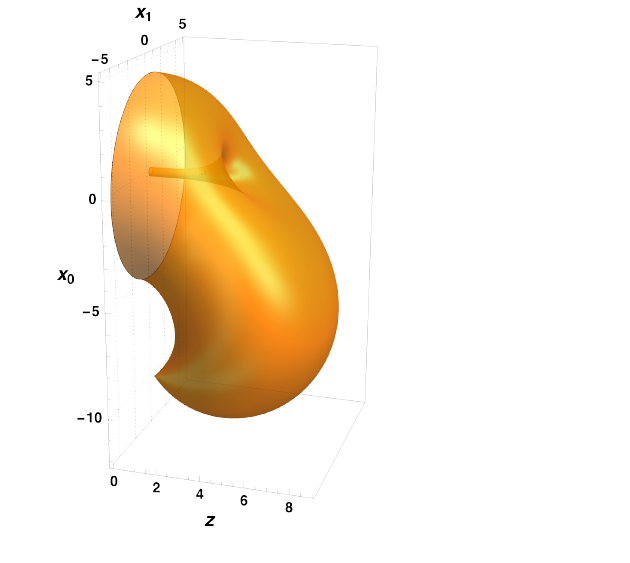
Figure 4 . A 2D contour of the Lagrangian density (3.24) (multiplied by the volume factor 4 πx 3 and for ρ = 1 , d = 10 ) evaluated at 1. An anti-instanton appears at x 0 = − 10 and x 1 = x 2 = x 3 = 0 (Euclidean coordinates x 2 , 3 are not shown) whose size grows and meets at z ∼ d the instanton located at x 0 = x 1 = 0